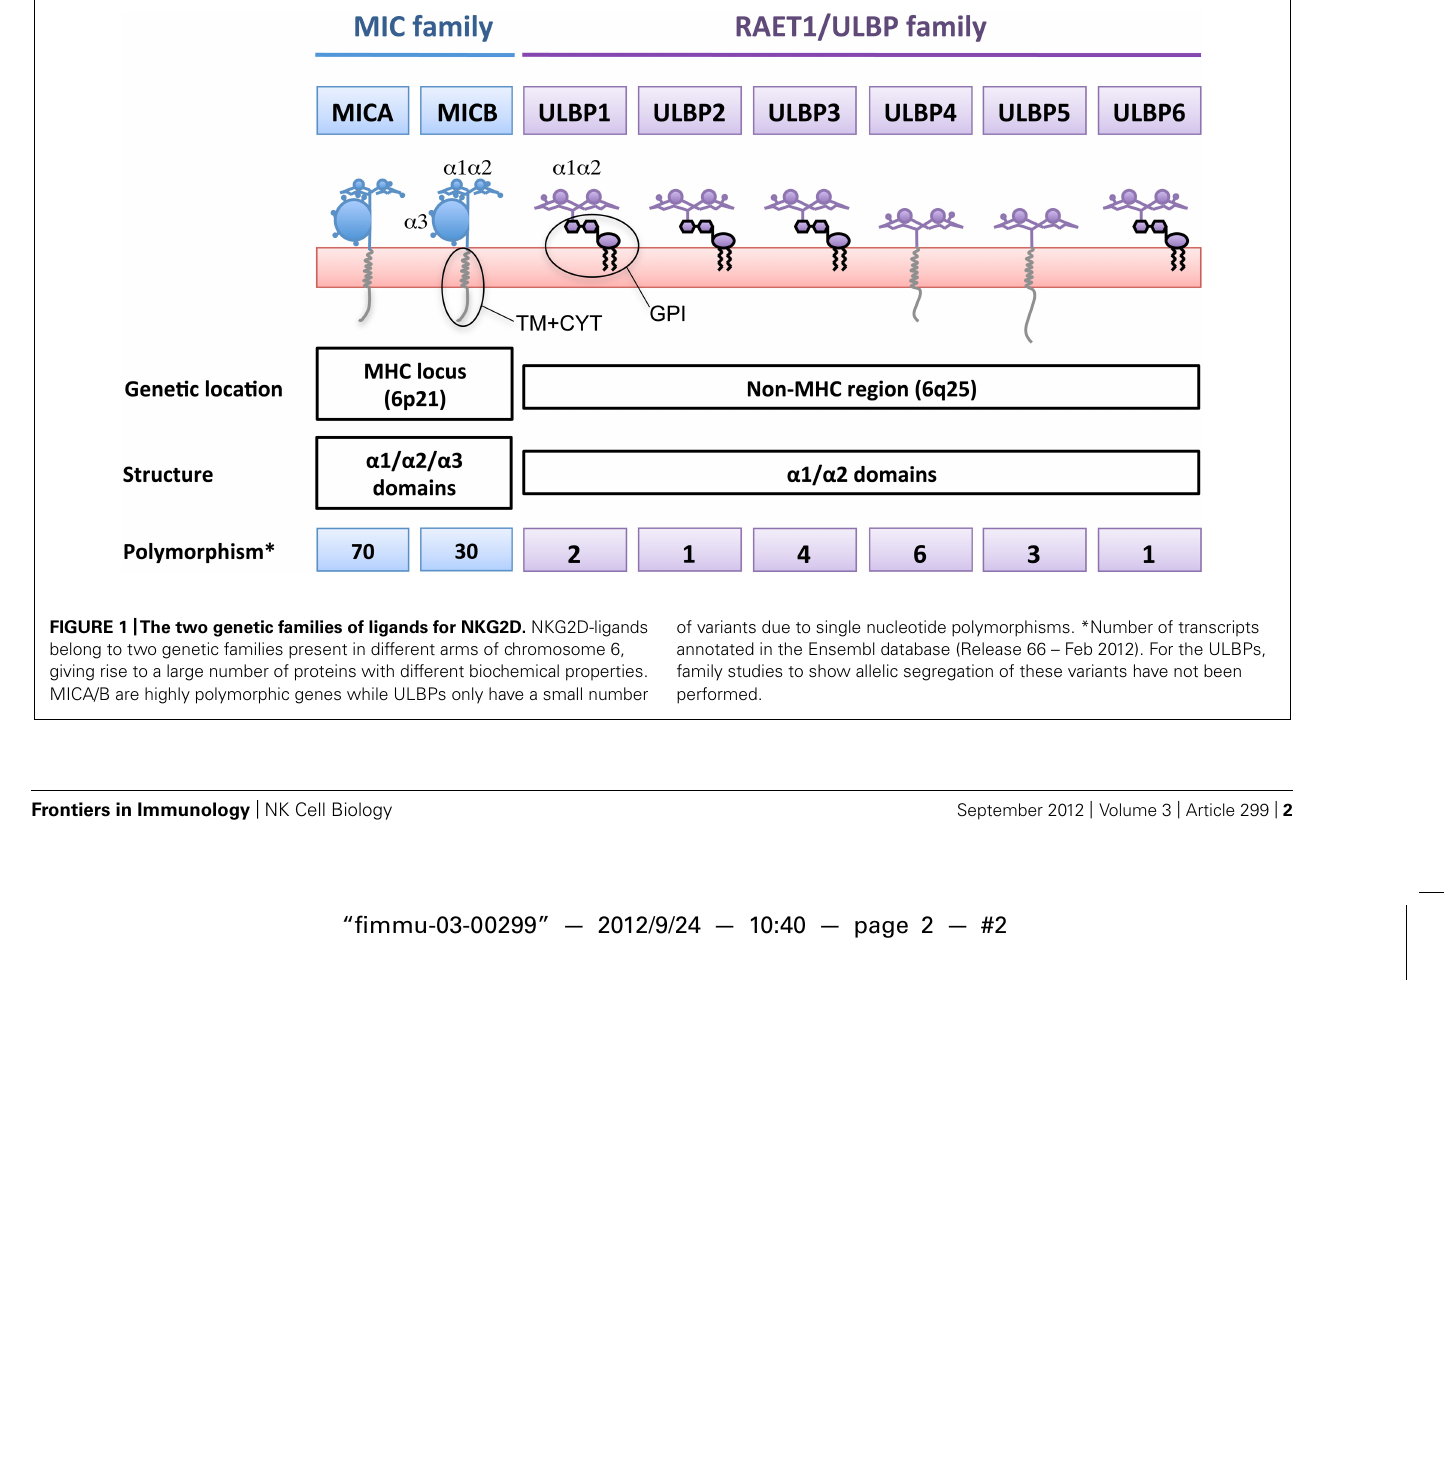
of variants due to single nucleotide polymorphisms. *Number of transcripts annotated in the Ensembl database (Release 66 – Feb 2012). For the ULBPs, family studies to show allelic segregation of these variants have not been